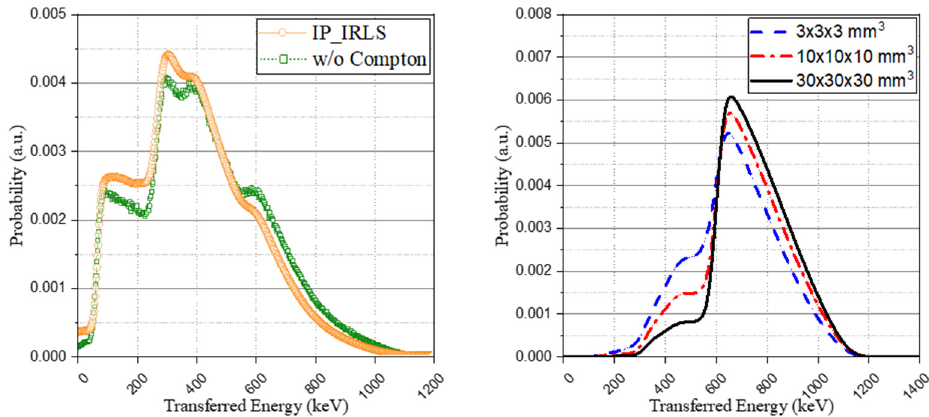
Figure 8. Comparison of the method without the Compton model (previous studies) ( left ) and base spectra of the eighth case depending on crystal structures ( right ).